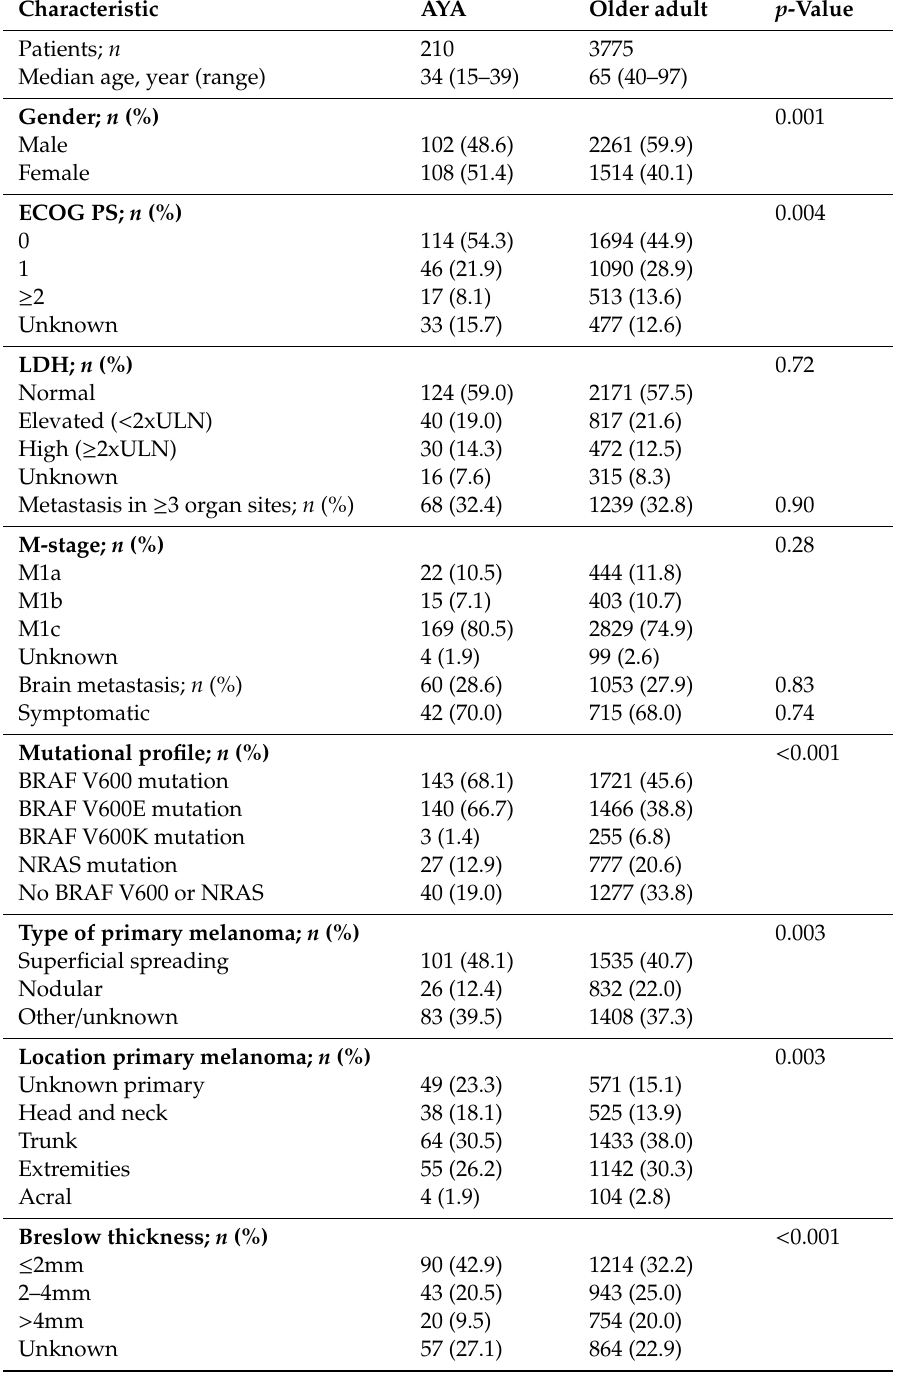
Table 1. Clinical and tumor characteristics of AYAs and older adult with advanced melanoma, and their primary melanomas. Eastern Cooperative Oncology Group (ECOG), lactate dehydrogenase (LDH), metastatic stage